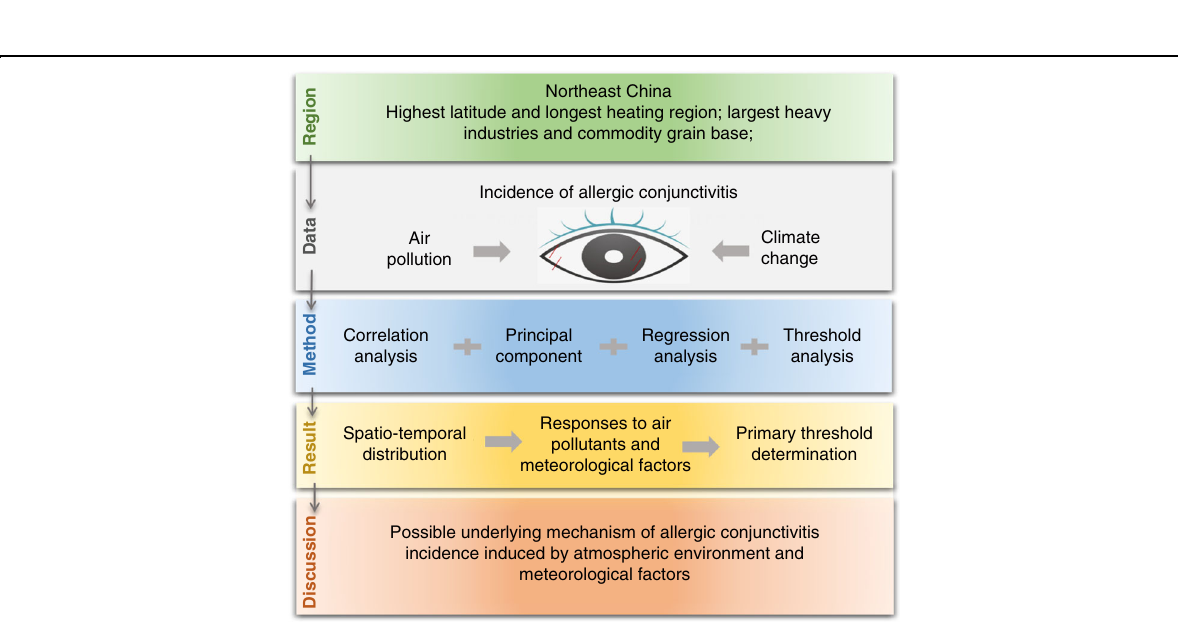
Fig. 8 Roadmap of research technology for the meteorological factors and atmospheric pollutants effect to the IAC in Northeast China. IAC incidence of allergic